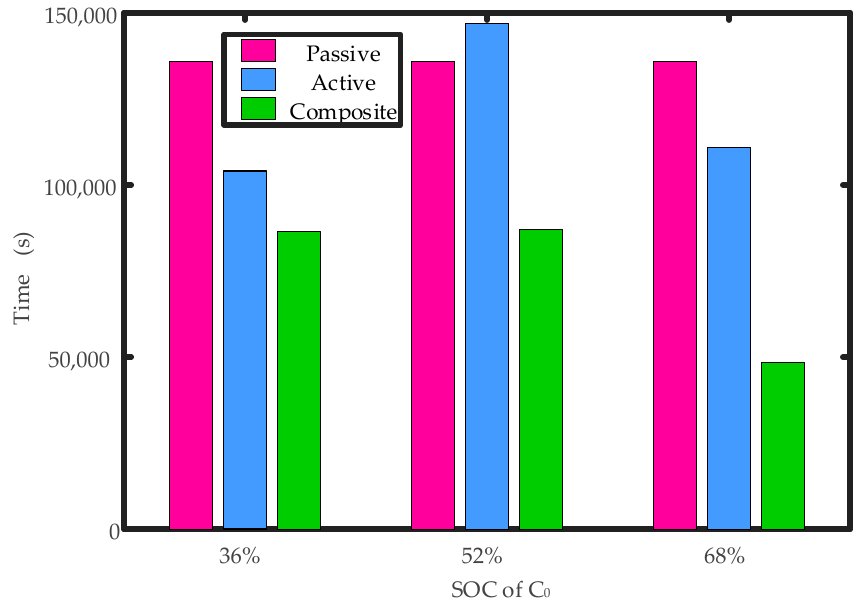
Figure 12. Comparison of simulation time for three different equalization methods.